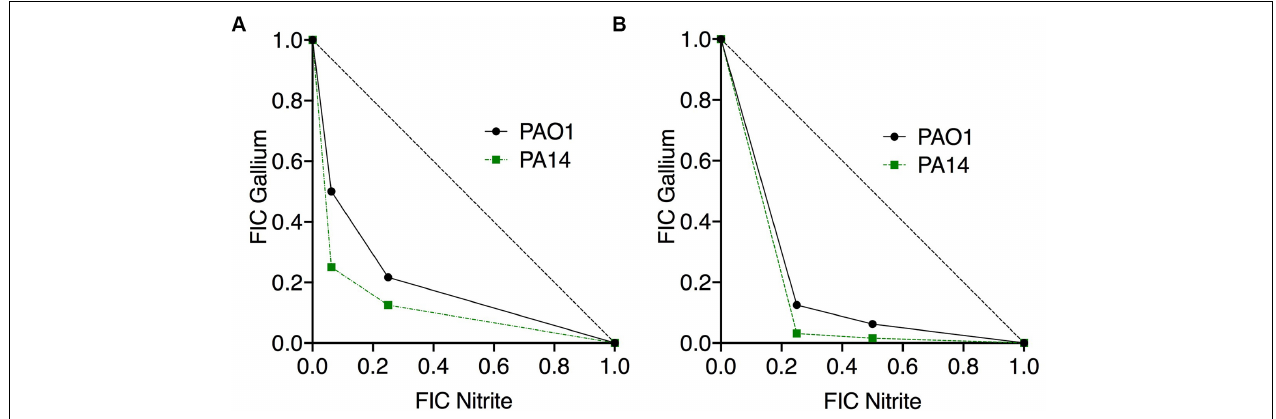
FIGURE 1 | Nitrite and Ga 3 + have synergistic antibacterial activity. Isobolograms show the results of checkerboard assays using PAO1 and PA14 presented showing the fractional inhibitory concentration (FICs) of the two compounds in combination under aerobic (A) and anaerobic (B) conditions. Six aerobic replicates done, three anaerobic replicates done, representative isobologram